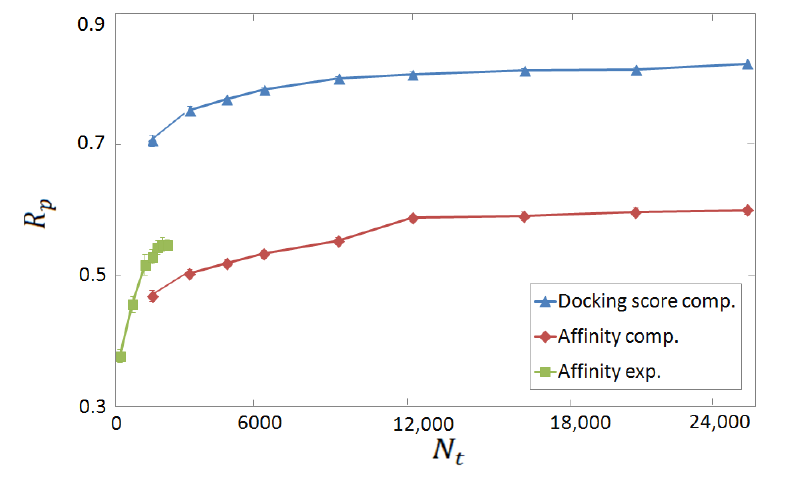
Figure 3. R p prediction–accuracy score as a function of the training set size N t . The green squares and the red rhombi correspond to the binding affinity prediction by the FCNN SFtrained on the experimental complexes and on the computer-generated databases, respectively. The blue triangles correspond to the predictions of the docking score by the FCNN SFtrained on the computer-generated database. The network structure is described in Figures 1 and